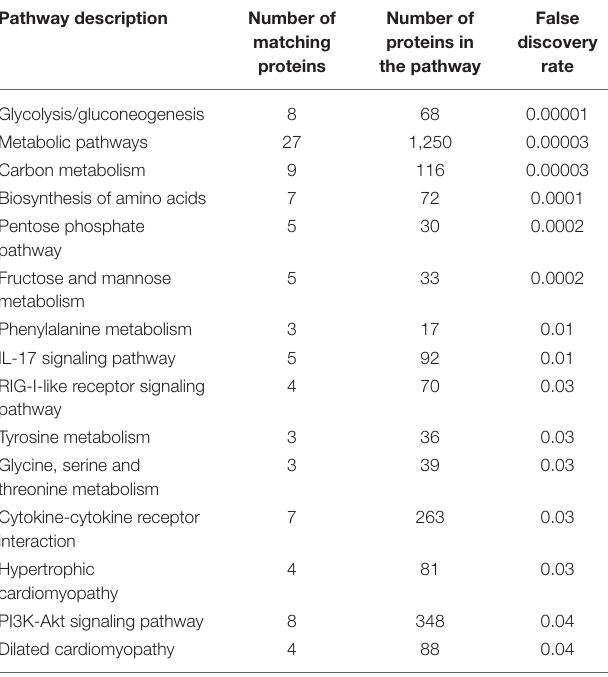
TABLE 3 | Pathways that are differentially regulated between patients with and without late gadolinium enhancement in the hypertrophic cardiomyopathy